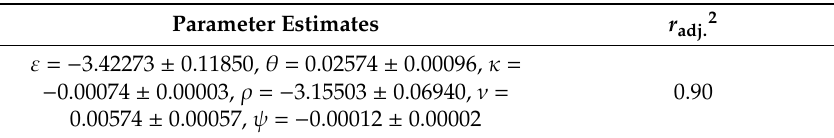
Table 7. Parameters estimated from the age- and temperature-dependent daily fecundity model (Equation (8)) of A. solani adults.